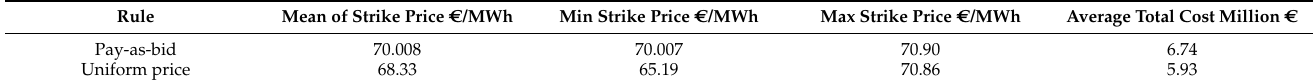
Table 6. Results of my own modelling for the pay-as-bid and the uniform price rules, source: [44] and own calculation.